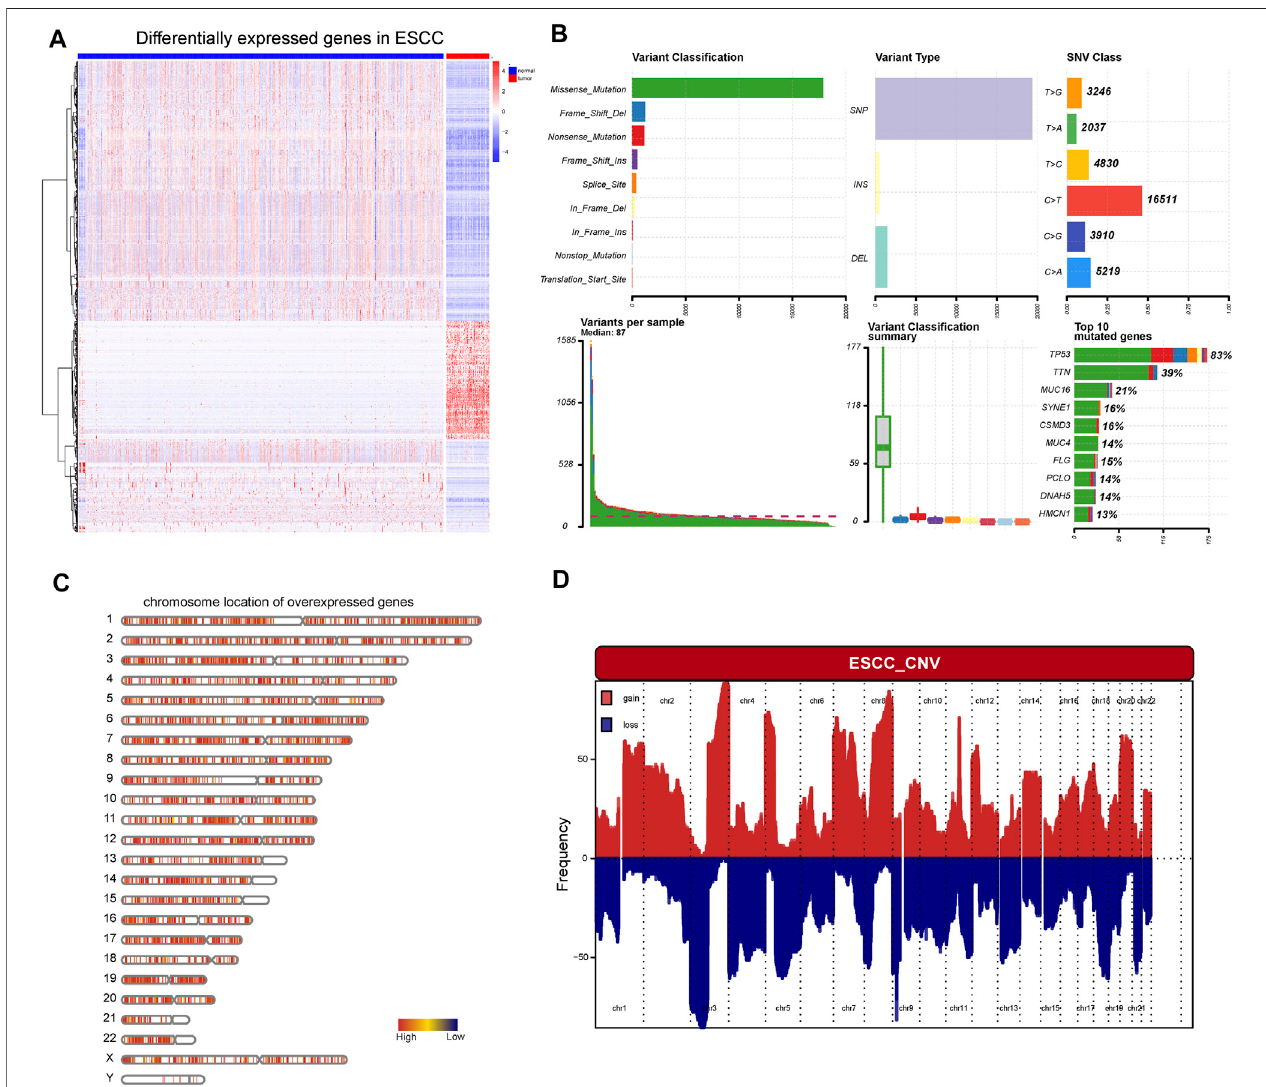
FIGURE 2 | Identi fi cation of potential tumor antigens of ESCC. (A) Heatmap showing the DEGs in ESCC, including over-expressed genes and under-expressed genes. (B) The mutation landscape of ESCC, including the variant classi fi cation, variant type, SNV class, variate per sample, variant classi fi cation, and top 10 mutated genes. (C) Chromosomal distribution of over-expressed genes in ESCC (D) The aberrant copy number genes in